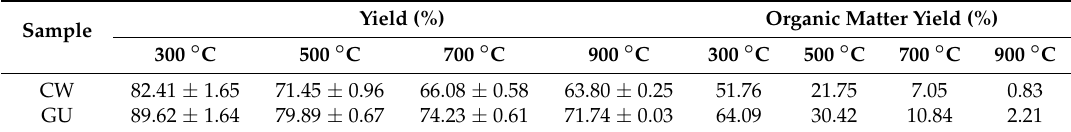
Table 3. Yields of each water treatment sludge char residue.